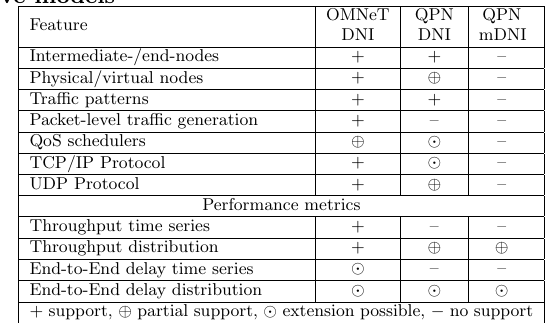
Table 2: Selected features of the compared predic- tive models